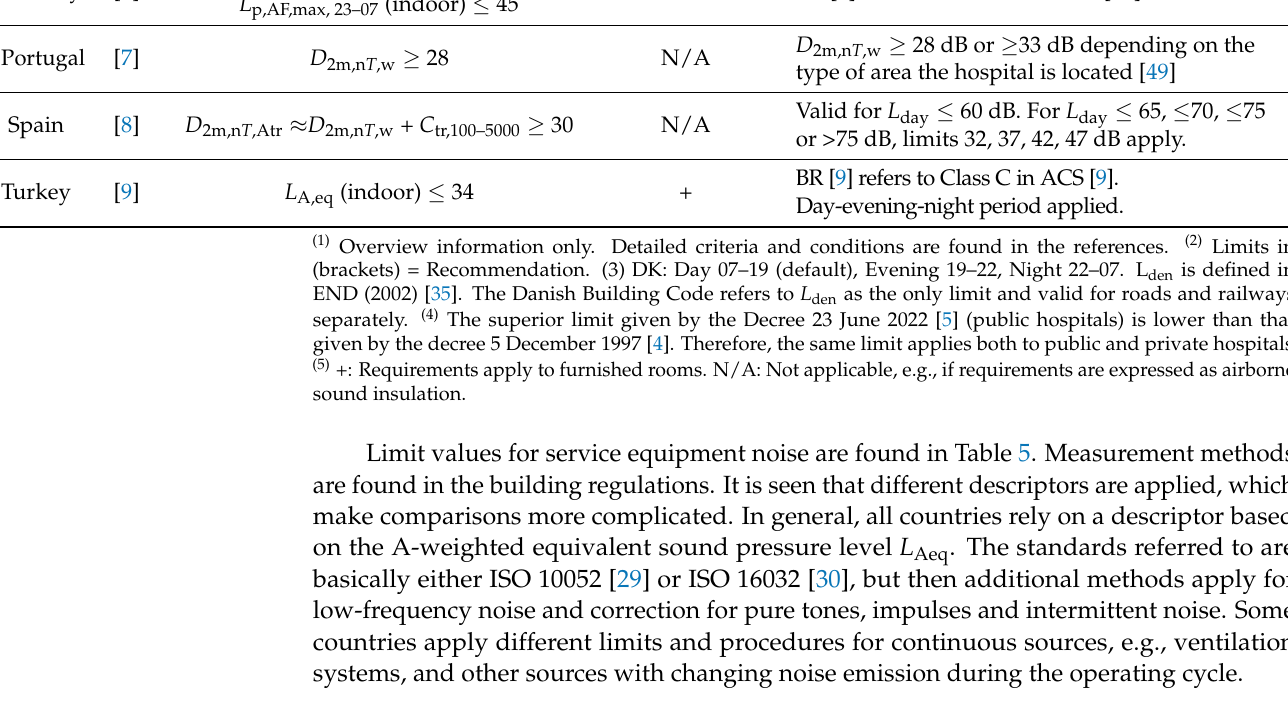
Table 5. Acoustic regulations for hospital bedrooms (1) —Service equipment noise. November